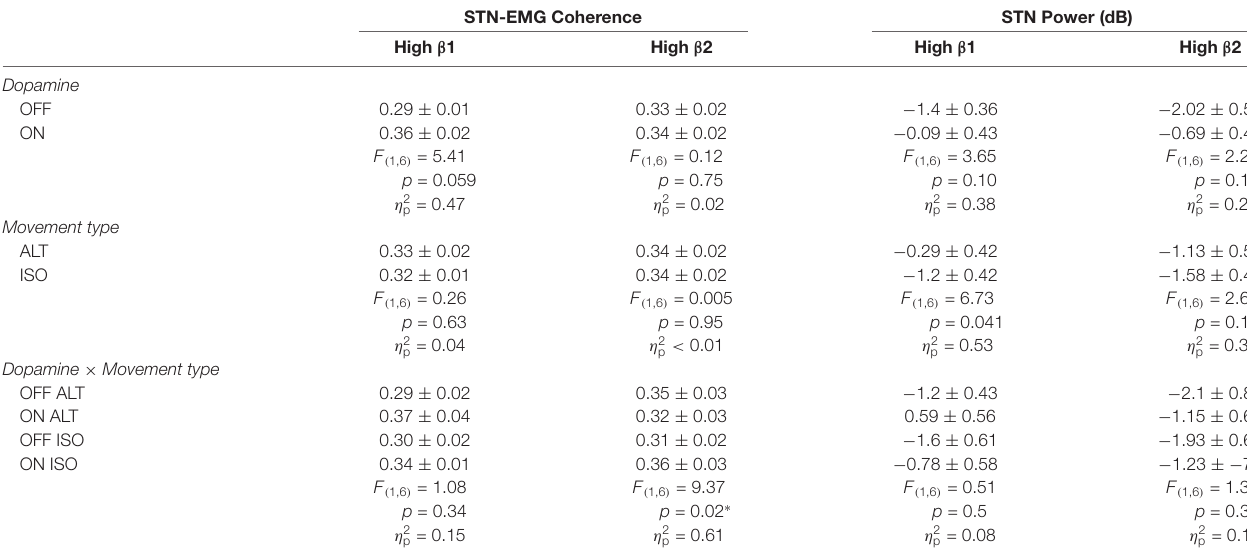
TABLE 1 | Summary of statistics of subthalamic nucleus (STN) and electromyogram (EMG) coherence and STN